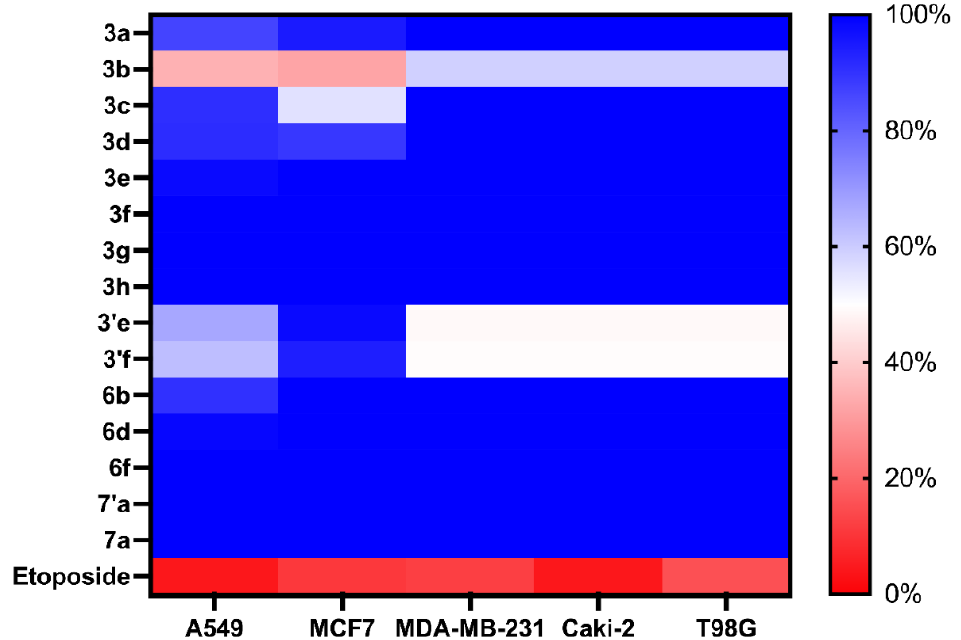
Figure 3. Cytotoxic activity (cell viability, %) of selected compounds against several cancer cell lines at 50 μM concentration.